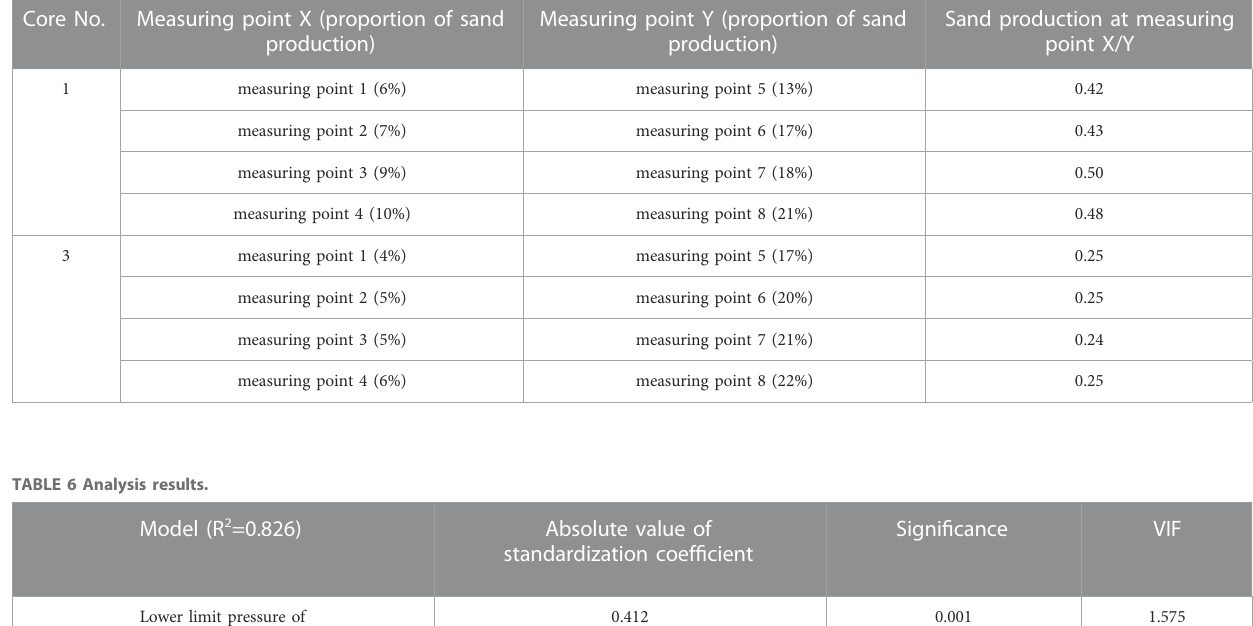
TABLE 5 Calculation table of sand production ratio. Core No.